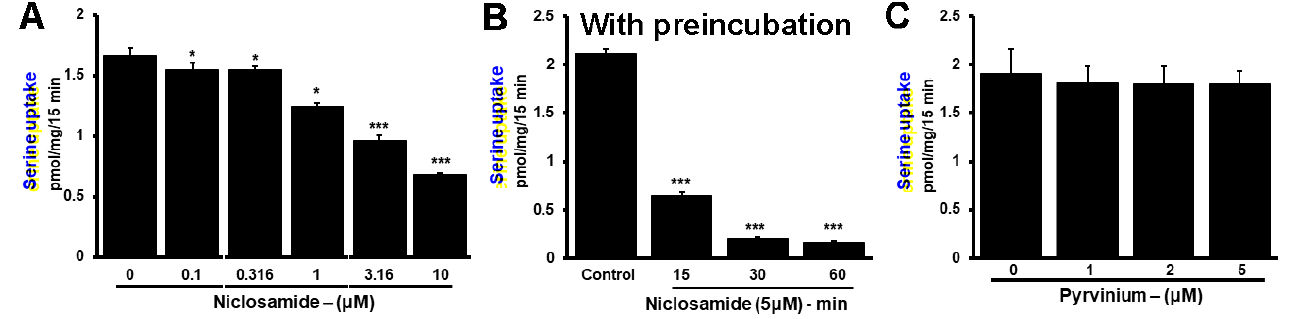
Figure 7. Potentiation of inhibition by niclosamide on SLC38A5 with preexposure of the cells to the drug. ( A ) Serine uptake (0.4 µ M) was measured in MB231 cells with niclosamide present only during uptake measurement. SLC38A5-mediated serine uptake was calculated as described in Figure 6. ( B ) The experiment was repeated again, but this time the cells were preexposed to 5 µ M niclosamide for 15, 30 or 60 min prior to initiation of uptake in the presence of 5 µ M niclosamide. Thus, niclosamide was present during preexposure as well as during uptake. ( C ) Lack of inhibition of SLC38A5-mediated uptake by pyrvinium. MB231 cells were used for serine uptake in the absence or presence of varying concentrations of pyrvinium during uptake. Measurements were made in two different buffers as described in Figure 6 to allow the determination of SLC38A5-mediated